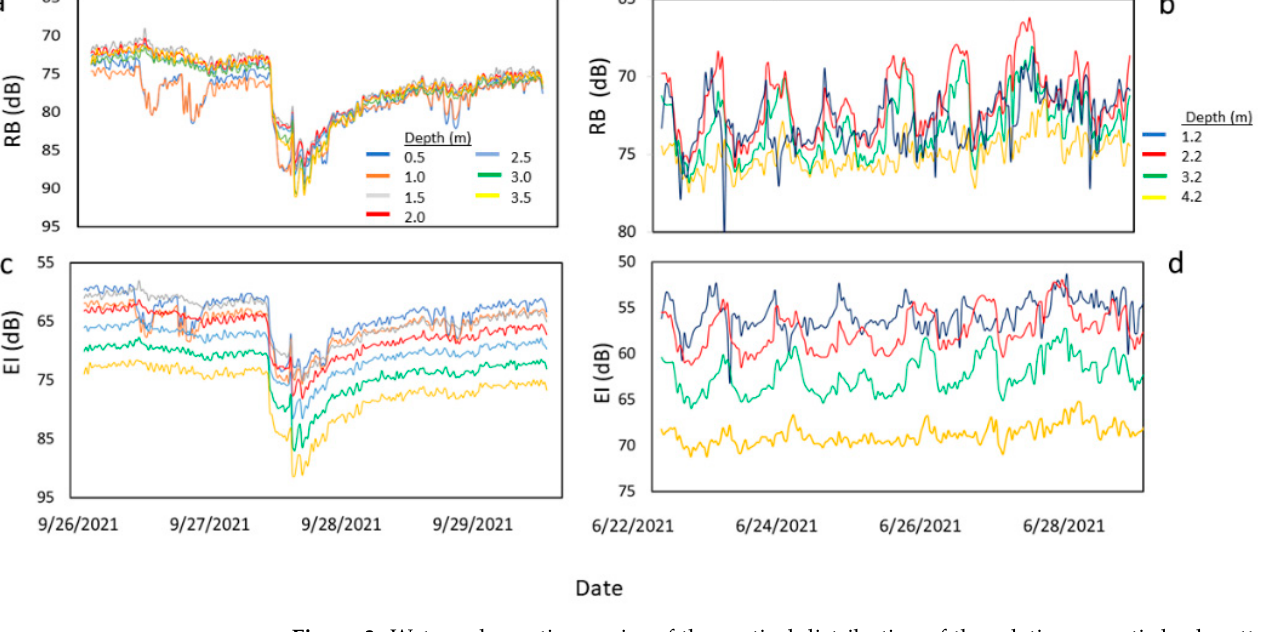
Figure 3. Water column time series of the vertical distribution of the relative acoustic backscatter (RB) (using the average of the beams of each preset bin), corrected for transmission losses, from the acoustic Doppler current profiler (ADCP) at the ( a ) upstream (UP) and ( b ) downstream (DS) sites. Time series of echo intensity (EI) at the UP ( c ) and DS ( d ) show greater differentiation between depths. Table 2. Total suspended solids (TSS, gravimetrically determined) and total particulate phosphorus (TPP) content of the TSS (TPP in TSS µ g mg − 1 ) and in the water column ( µ g L − 1 ), with increasing depth from the water surface of the L-29 Canal. The TSS values were used to calibrate the echo intensity (EI) from the acoustic Doppler velocimeter (ADV) and the acoustic Doppler current profiler